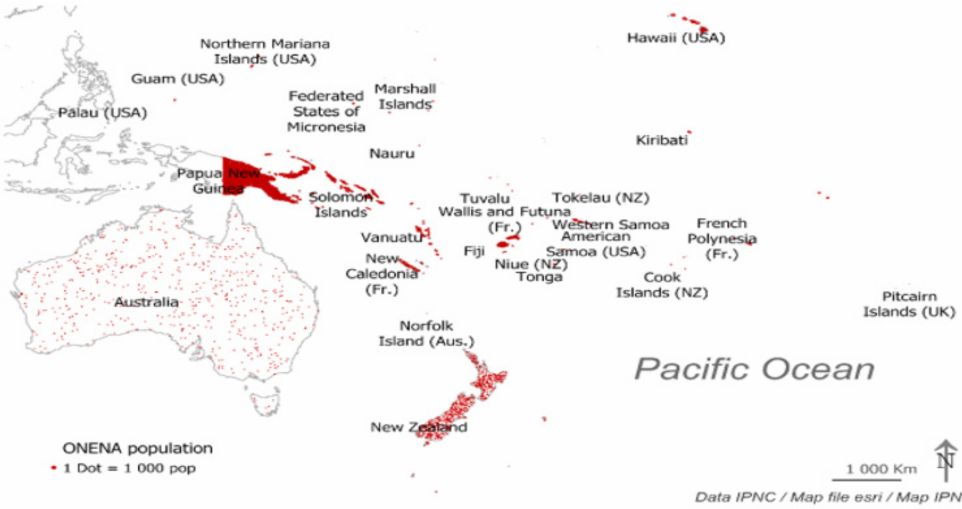
Figure 1. Oceania and relative estimates of population subgroups. Adapted from